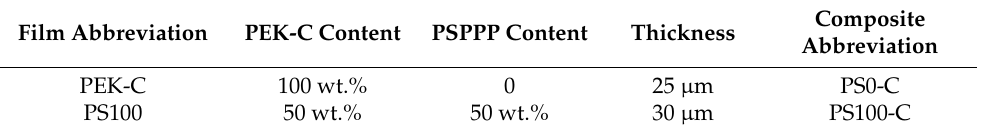
Table 1. Properties of the film interleaf and abbreviations.